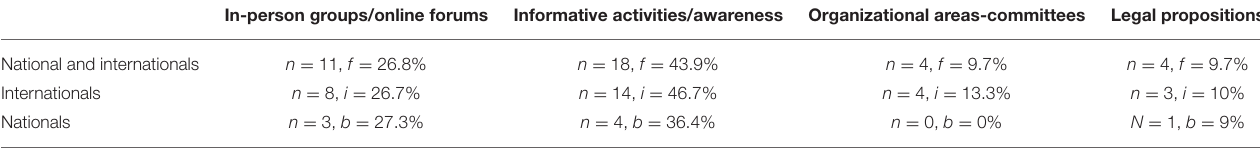
TABLE 4 | Format of